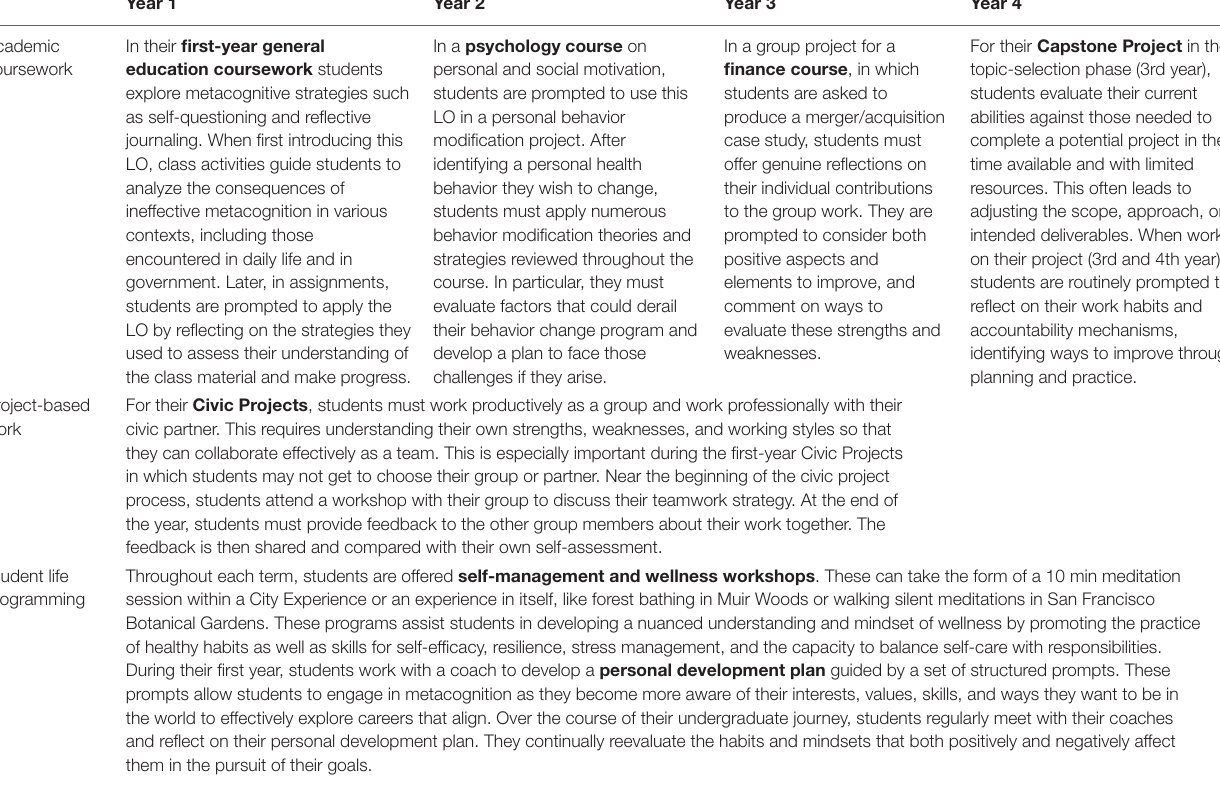
TABLE 3 | Integration of use and assessment of #selfawareness across Students’ 4-year